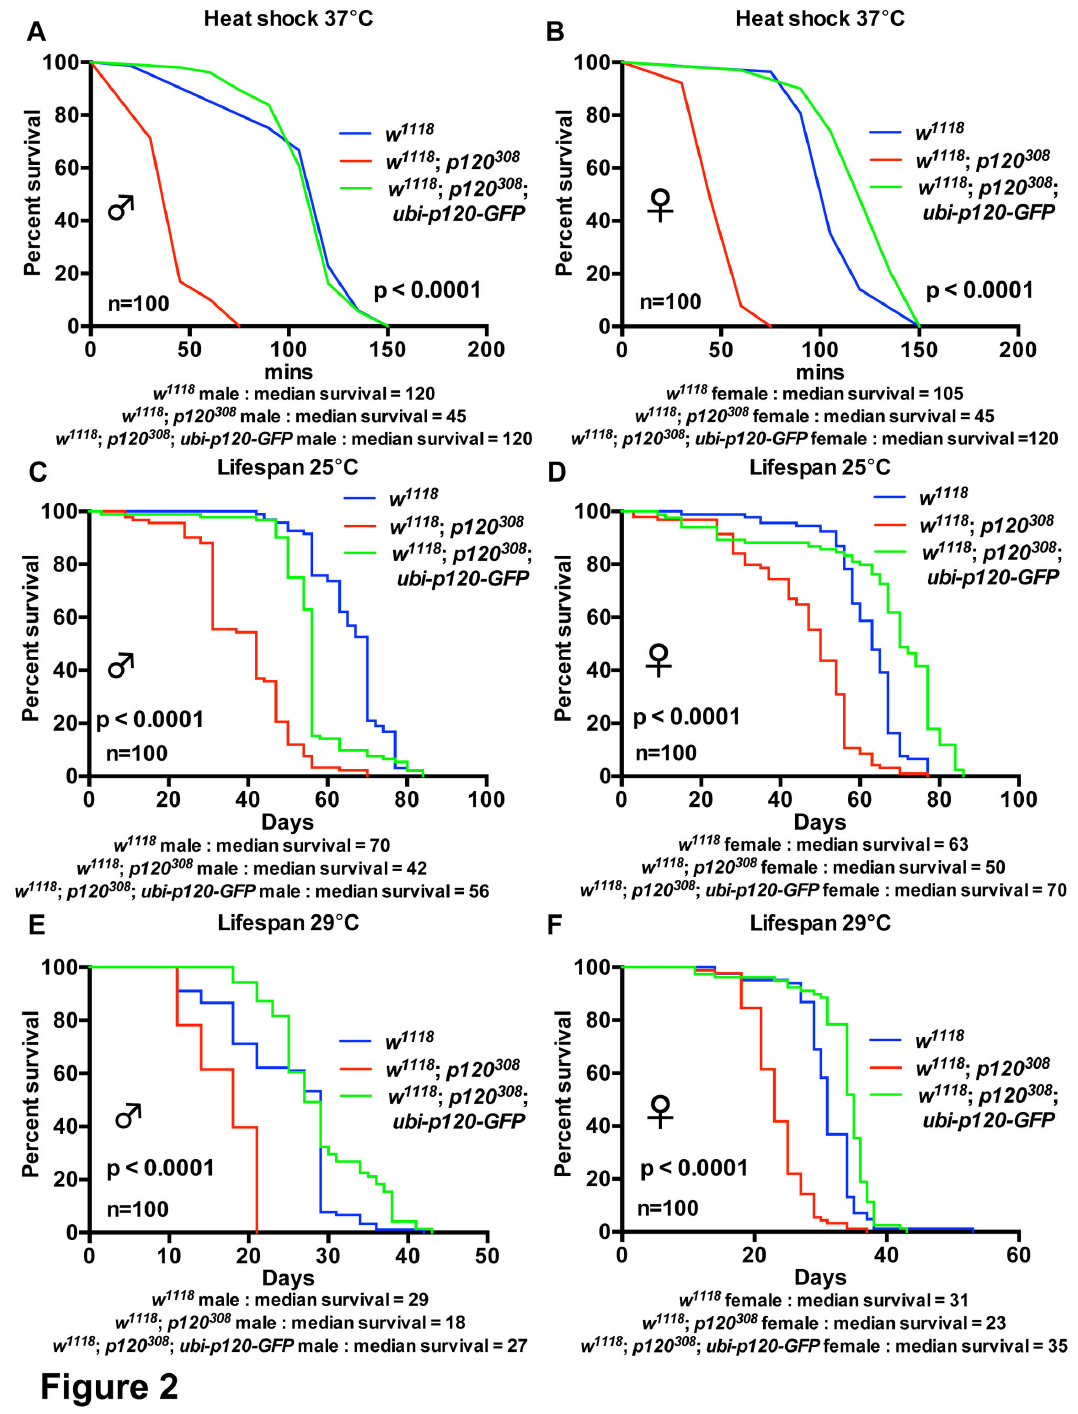
Figure 2. Ubiquitous Expression of dp120ctn-GFP rescues dp120ctn mutants. (A-B) Survival of w 1118 , w 1118 ; p120 308 and w 1118 ; p120 308 ; ubi-p120-GFP males and females under heat shock conditions. Survival was plotted as adult survival in minutes under heat shock at 37°C. (C-F) Lifespan of w 1118 and w 1118 ; p120 308 and w 1118 ; p120 308 ; ubi-p120-GFP males and females at 25°C and 29°C. Survival was plotted as adult lifespan in days. Blue lines indicate w 1118 controls, red lines w 1118 ; p120 308 and green lines w 1118 ; p120 308 ; ubi-p120ctn-GFP . Each curve represents 100 flies. Median survival is presented for each cohort and p value generated using log-rank tests and refer to comparison between red lines ( w 1118 ; p120 308 ) and green lines ( w 1118 ; p120 308 ; ubi-p120ctn-GFP ). doi: 10.1371/journal.pone.0083942.g002 PLOS ONE |